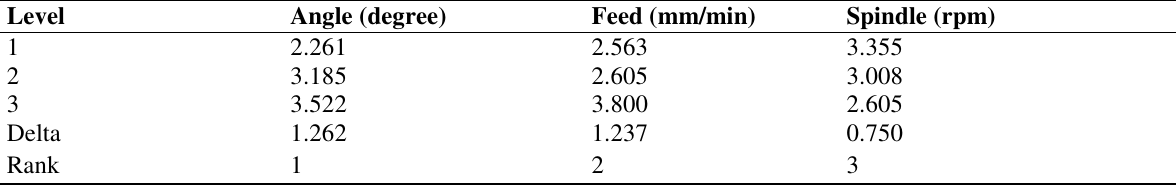
Response table for means.